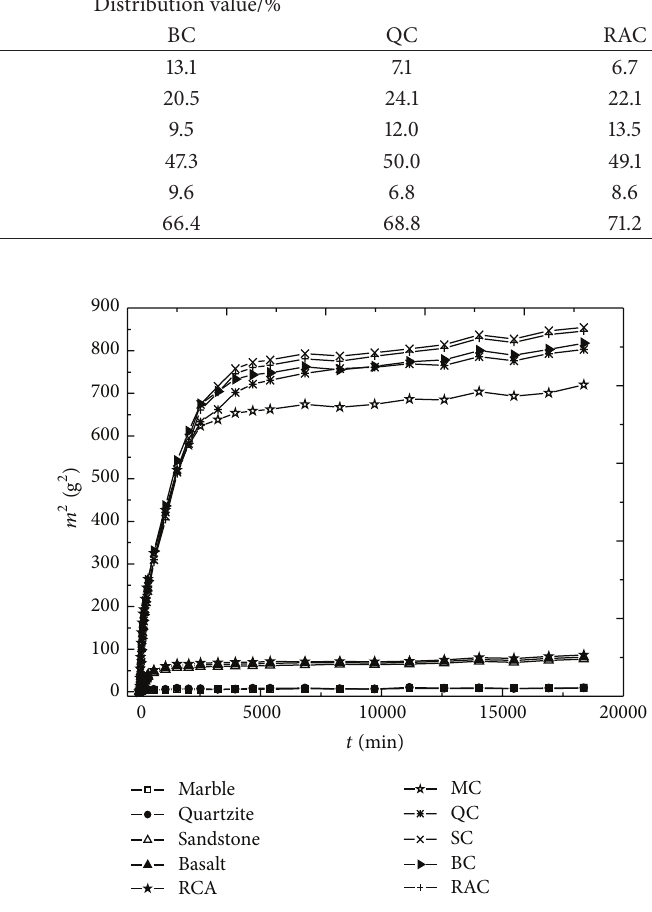
Figure 2: Curve of pore distribution ratios of different coarse aggre- gate concretes.